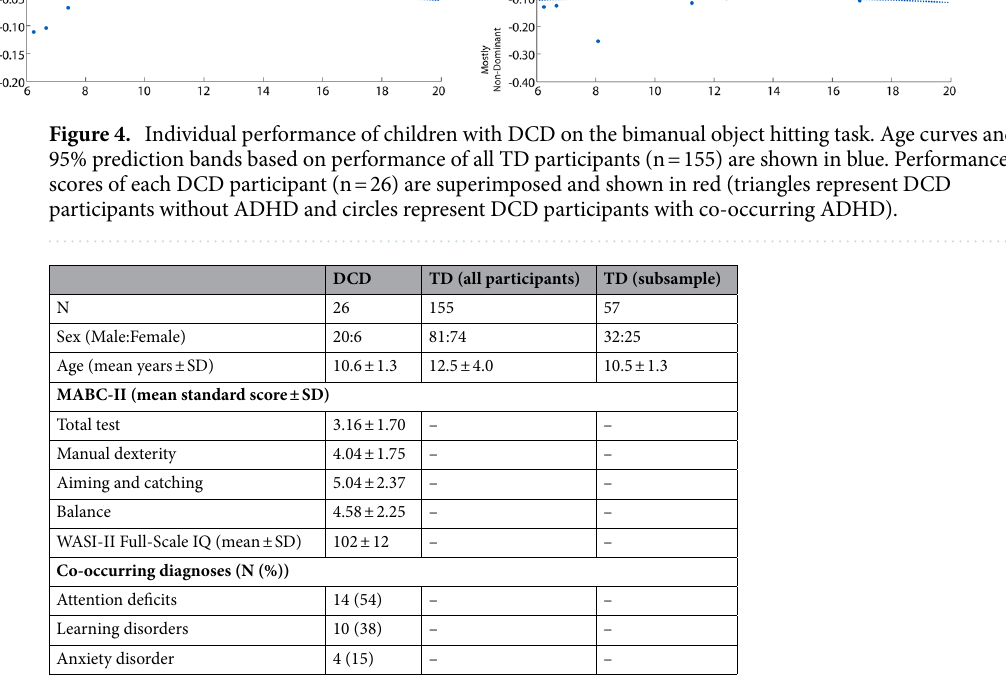
Table 1. Participant demographics and clinical